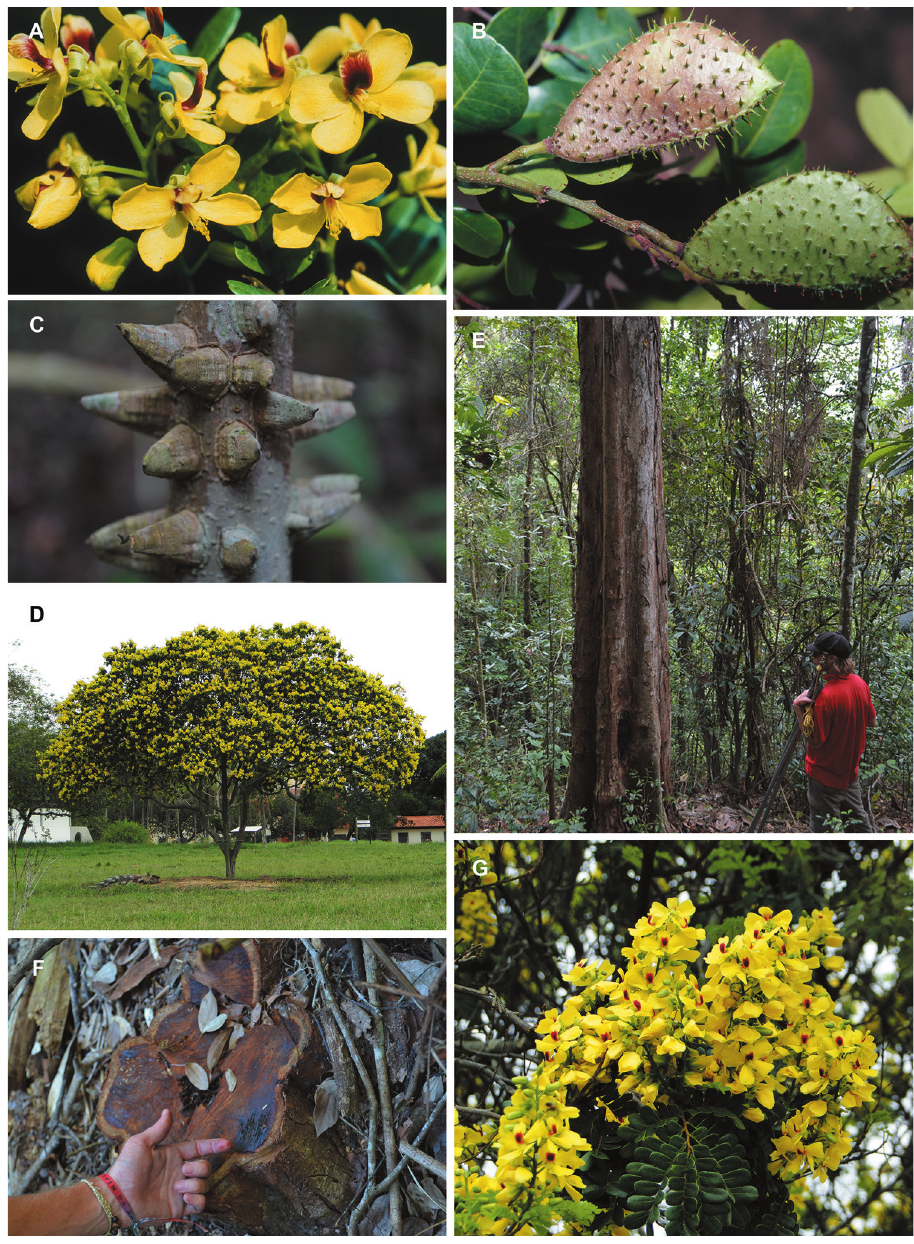
Figure 9. Paubrasilia echinata (Lam.) E. Gagnon, H. C. Lima & G. P. Lewis. A flowers (H.C. Lima, Brazil, Lima et al. 2705 (RB)) B fruits (G. P. Lewis, Brazil, unvouchered ) C prickles on woody protuber- ances on a young trunk (E. Gagnon, Bahia, Brazil, Lima et al. 7909 (RB)) D habit (L. P. de Queiroz, Bahia, Brazil, unvouchered ) E fluted trunk of a mature individual (E. Gagnon, Bahia, Brazil, Lima et al. 7894 (RB) F cross section of the trunk, showing dark red heartwood (E. Gagnon, Espirito Santo, Brazil, unvouchered ), G inflorescences (L. P. de Queiroz, Bahia, Brazil, unvouchered